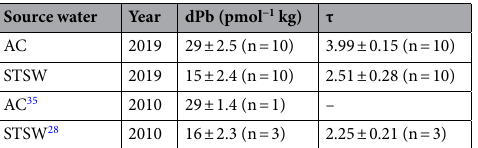
Table 2. End member values of variables used in the mixing calculations. –, data unavailable.